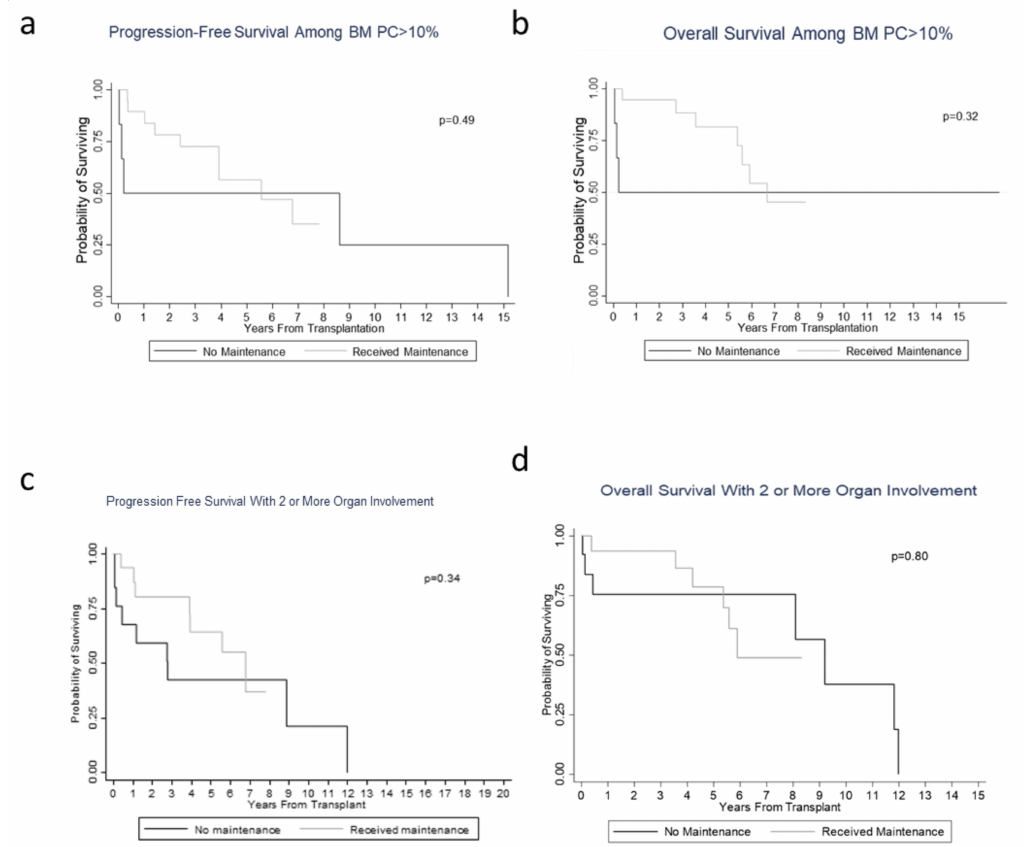
Figure 2. Kaplan–Meier curve demonstrating survival measured from maintenance. ( a ) Progression-free survival among patients with ≥ 10% plasma cell burden with or without maintenance. ( b ) Overall survival among patients with ≥ 10% plasma cell burden with or without maintenance. ( c ) Progression-free survival among patients with ≥ 2 organs with or without maintenance. ( d ) Overall survival among patients with ≥ 2 organs with or without